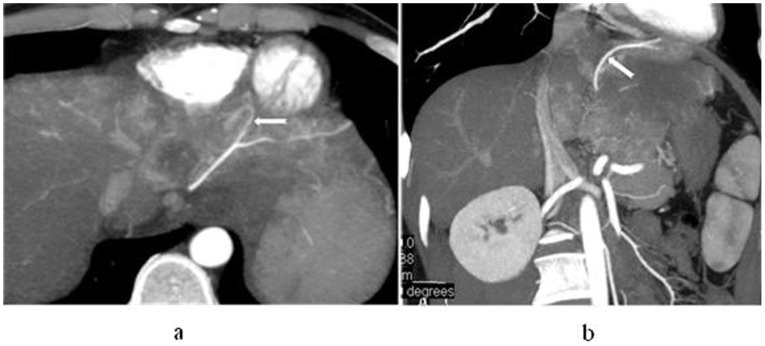
In a 31-year-old man with hepatocellular carcinoma in S2 and S3, left inferior phrenic artery participates in blood supply for the tumour.Axial (a) and coronal (b) maximum intensity projection display that left inferior phrenic artery is enlarged apparently (white arrow) and its branches into the tumor (white arrow).